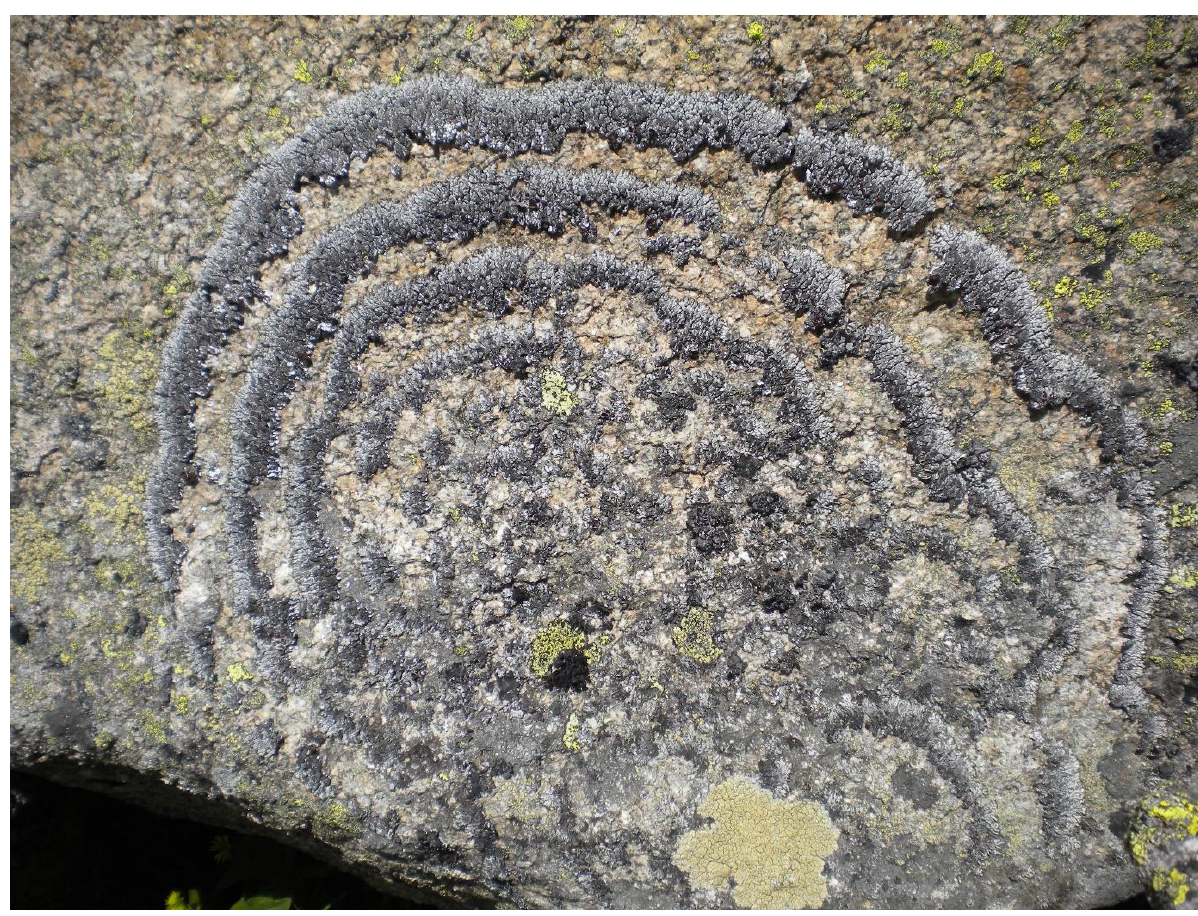
FIGURE 1: Brodoa atrofusca , alpine rock inhabiting lichen frequently growing in wave-like concentric fashion. Thallus diameter c. 60 cm (Hohe Tauern, Austria. Foto: Martin